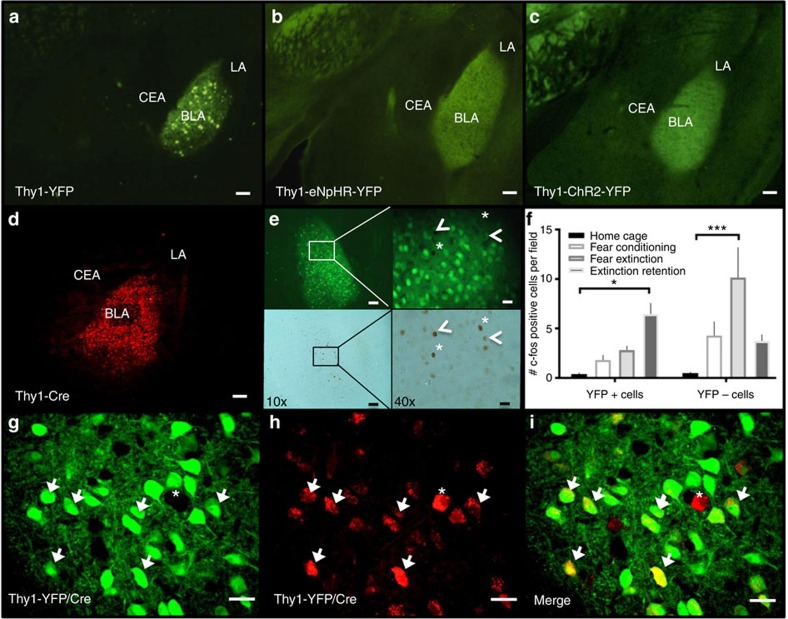
Thy1 lines mark BLA population that is active during expression of fear extinction.(a) Thy1-eYFP, (b) Thy1-eNpHR, (c) Thy1-ChR2, each have strong expression enriched in the BLA. (d) Cre recombinase driven by the Thy1.2 cassette in the Thy1-cre mouse, when visualized via infusion of AAV- hSyn-DIO-rM3D(Gs)-mCherry, marks the same regional population as marked by the Thy1-eYFP mouse. (e) Representative images of a field of view analysed for c-fos staining in the BLA of Thy1-YFP mouse after fear expression. Co-localization was manually scored at × 40 magnification, × 10 images are for reference. Upper panels: YFP+ expression in BLA of examined Thy-1 YFP mice. Green neurons in upper panels are YFP+ neurons while black c-fos+ nuclei are depicted in lower panels. Fields for analysis were chosen at random within strongly YFP expressing area. Fields of were visually inspected for co-labelling of c-fos and YFP. Example neurons identified: arrowhead indicates c-fos+/YFP+ cell, while asterisk indicates c-fos+/YFP− cell. (f) Quantification of co-labelling of YFP or non-YFP-marked cells with c-fos in Thy1-eYFP mouse. Counts represented as number of positive events per field analysed. BLA sections were analysed after (1) untrained home cage controls (HC), (2) fear conditioning (FC), (3) fear extinction (FE) or (4) fear extinction retention (FR). Thy1-eYFP+ neurons are c-fos+ significantly more often after fear extinction testing versus home cage, while eYFP-marked neurons stain for c-fos significantly more often during fear expression (two-way ANOVA, F(3,40)
P=0.0017, when significant main or interaction effects were found by the ANOVAs, Sidak's post hoc tests were carried out to locate simple effects. Sidak's multiple comparisons versus home cage: *P<0.05, *P<0.005, error bars indicate ±s.e.m. Sidak's multiple comparison post hoc analysis: YFP+ HC versus YFP− FE P<0.05, YFP+ FC versus YFP− FE P<0.05, YFP+ FE versus YFP− FE: P<0.05, YFP− HC versus YFP− FE P<0.05, YFP− FE versus YFP− FR: P<0.05, error bars indicate mean±s.e.m.). (g–i) Infusion of AAV-EF1a-DIO mCherry into double transgenic Thy1-eYFP/Thy1-Cre mouse allows co-localization of neurons marked by each transgene. Arrows indicate neurons with co-localization. Asterisks indicate neuron marked only by mCherry. Scale bar, 100 μm (a–d, e upper left and lower left); scale bar, 20 μm for (g–i, e upper right and lower right).